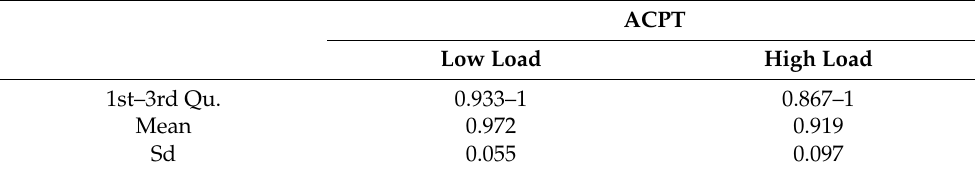
Table 3. Descriptive table for the ACPT score, reported separately for ACPT-X (Low Load) and -AX (High